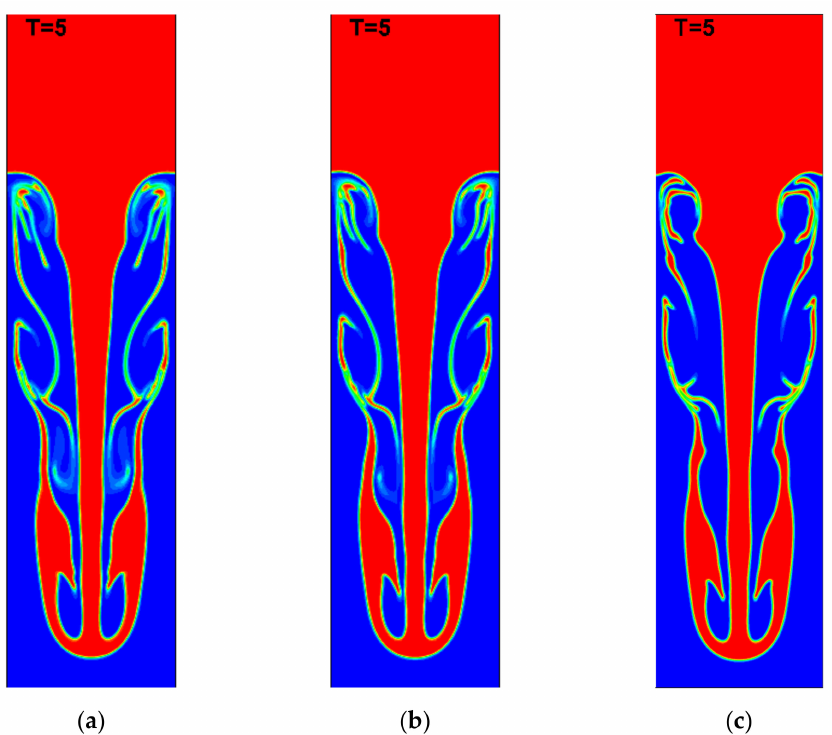
Figure 18. Interface shapes for Rayleigh–Taylor instability of Re = 3000 (T = 5): ( a ) original method, ( b ) present method with k 1 = 1, ( c ) present method with k 1 =